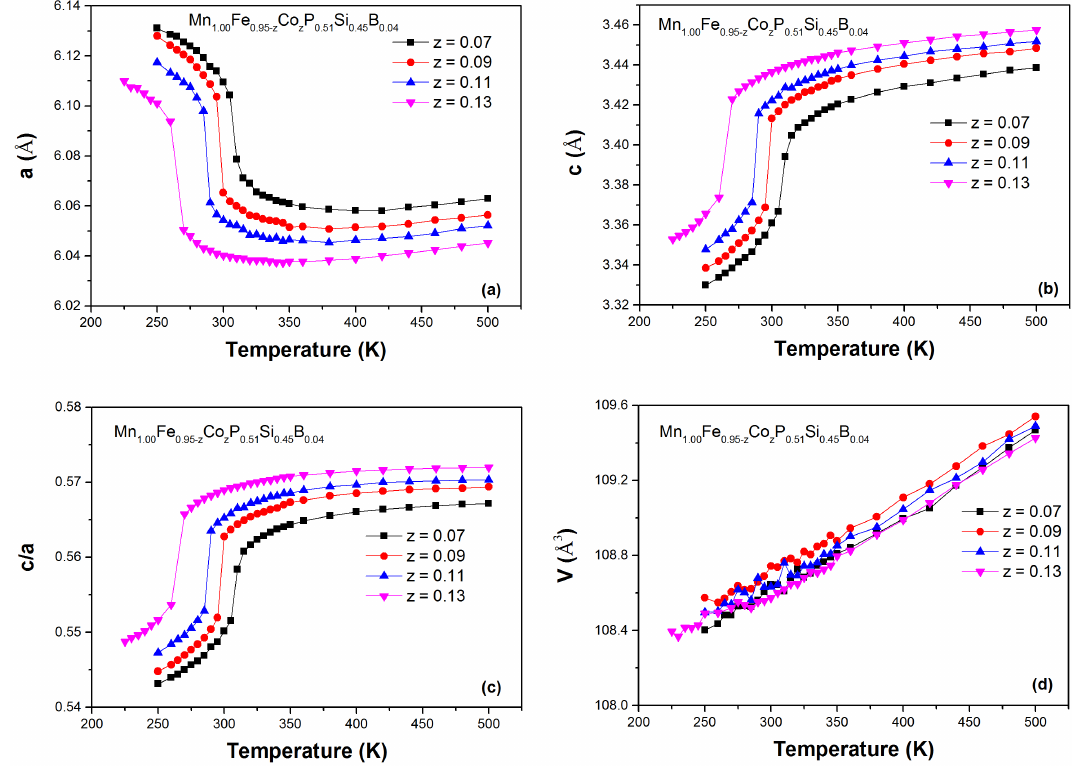
Figure 7. Temperature dependence of the lattice parameters a ( a ) and c ( b ), the c / a ratio ( c ) and the unit-cell volume V ( d ) for the Mn 1.00 Fe 0.95 − z Co z P 0.51 Si 0.45 B 0.04 compounds with z = 0.07, 0.09, 0.11 and 0.13, derived from XRD patterns measured upon